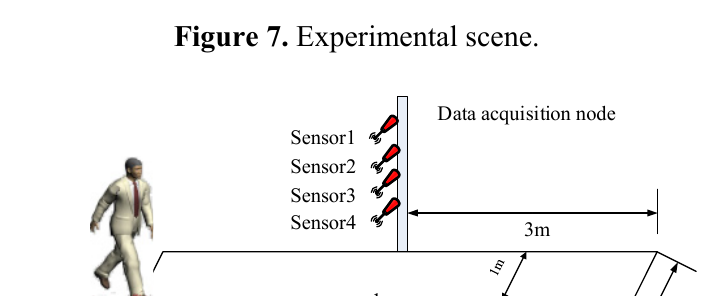
Figure 7. Experimental